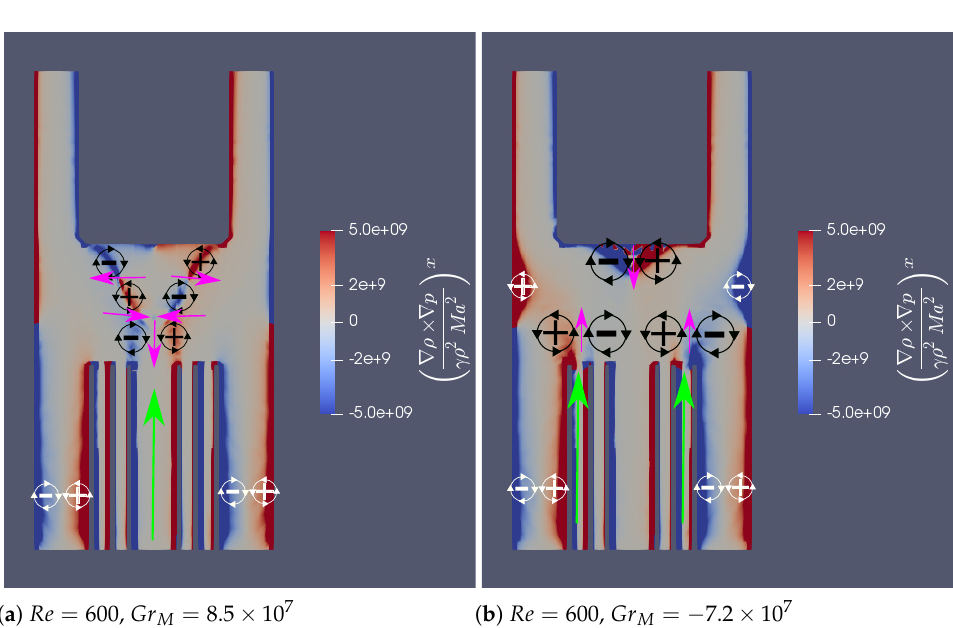
Figure 11. Vertical cut through the up-flow reactor depicting the distribution of the x − component of the baroclinic term. Black circles denote the baroclinic torque due to molar mass gradients. White circles denote the baroclinic torque due to thermal gradients. Green arrows give the intended direction of flow and purple arrows denote the acceleration of the fluid due to the baroclinicity. ( a ) Variation of NH 3 in the ORL. ( b ) Variation of H 2 in the IRL.